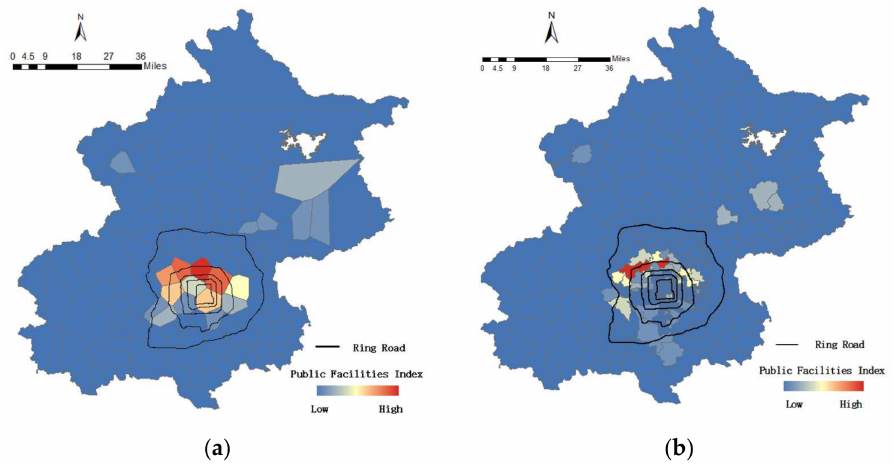
Figure 8. Public facilities index distribution in ( a ) 147-polygon Voronoi diagram, ( b ) 328